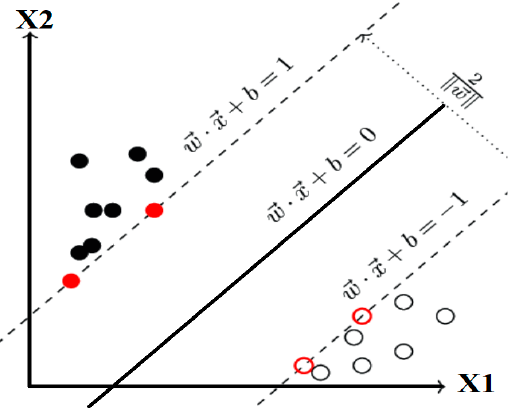
ω + = . Figure 1. Position of hyper parameters in support vector regression (SVR) ω . x + b =